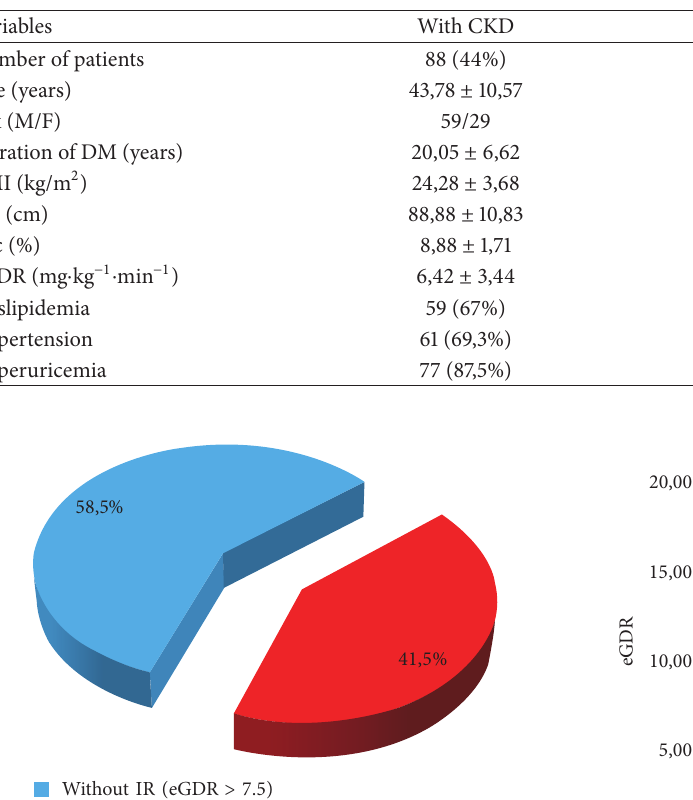
Table 2: Characteristics of patients with CKD.